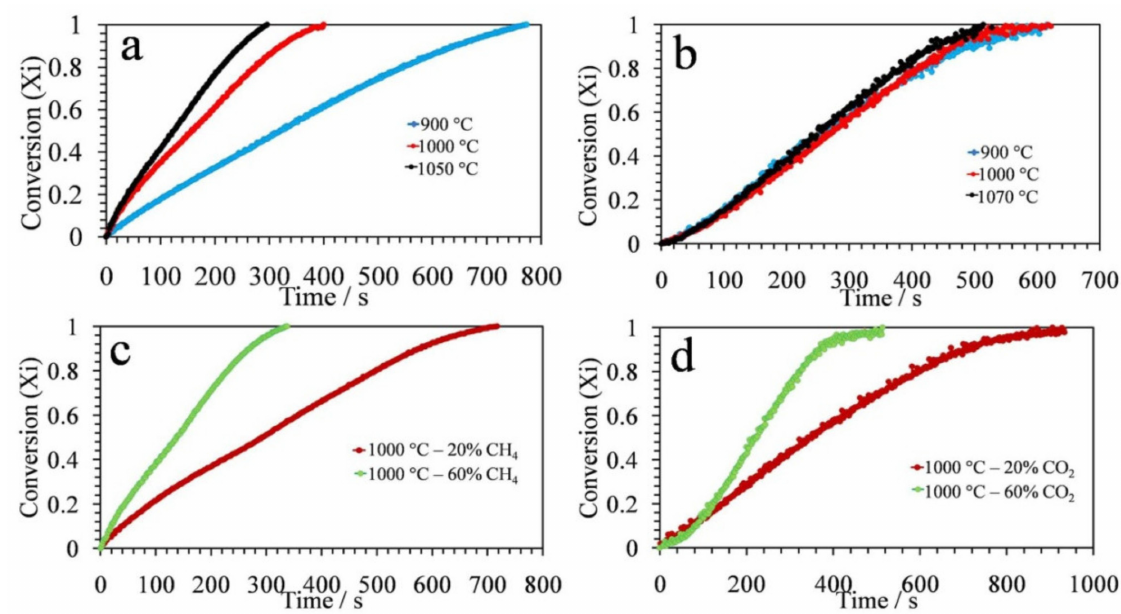
Figure 4. Experimental solid-state conversion profiles as a function of time ( a ) at selected temperatures during reduction and ( b ) at selected temperatures during re-oxidation, ( c ) effect of CH 4 partial pressure during reduction, and ( d ) effect of CO 2 partial pressure during re-oxidation. The partial pressure of the reactant gases was kept at 40% in ( a , b ). Experiments with varying partial pressures in ( c , d ) were carried out at 1000 ◦